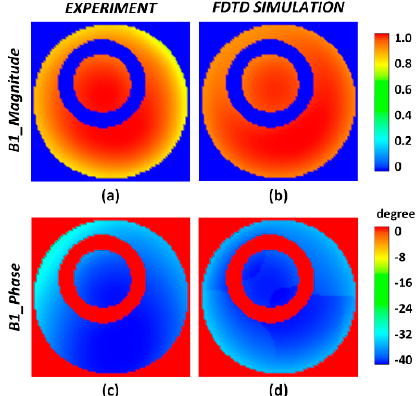
Figure 6. ( a ) and ( c ) indicate the magnitude and phase of the measured B + the magnitude and phase of the calculated B +